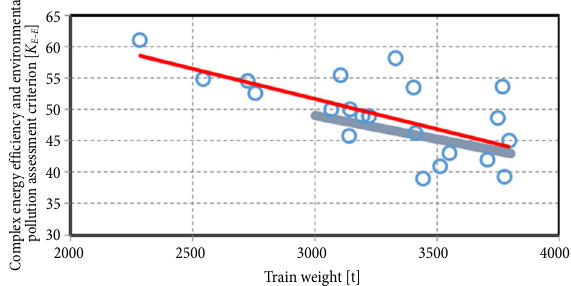
Fig. 7. Theoretical ant actual values of complex K E–E criteria values of a single section locomotive ER20CF on the railway line Radviliškis–Draugystė: o – operational experimental points; — – theoretical trend; — – actual data